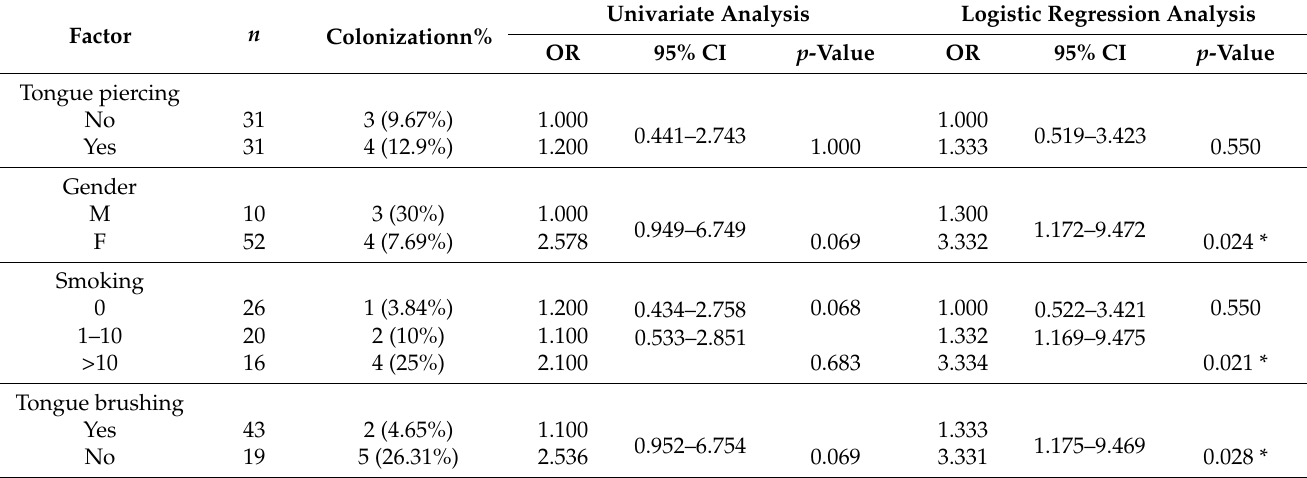
Table 1. Univariate and logistic regression analysis of possible risk factors for Candida colonization in the study